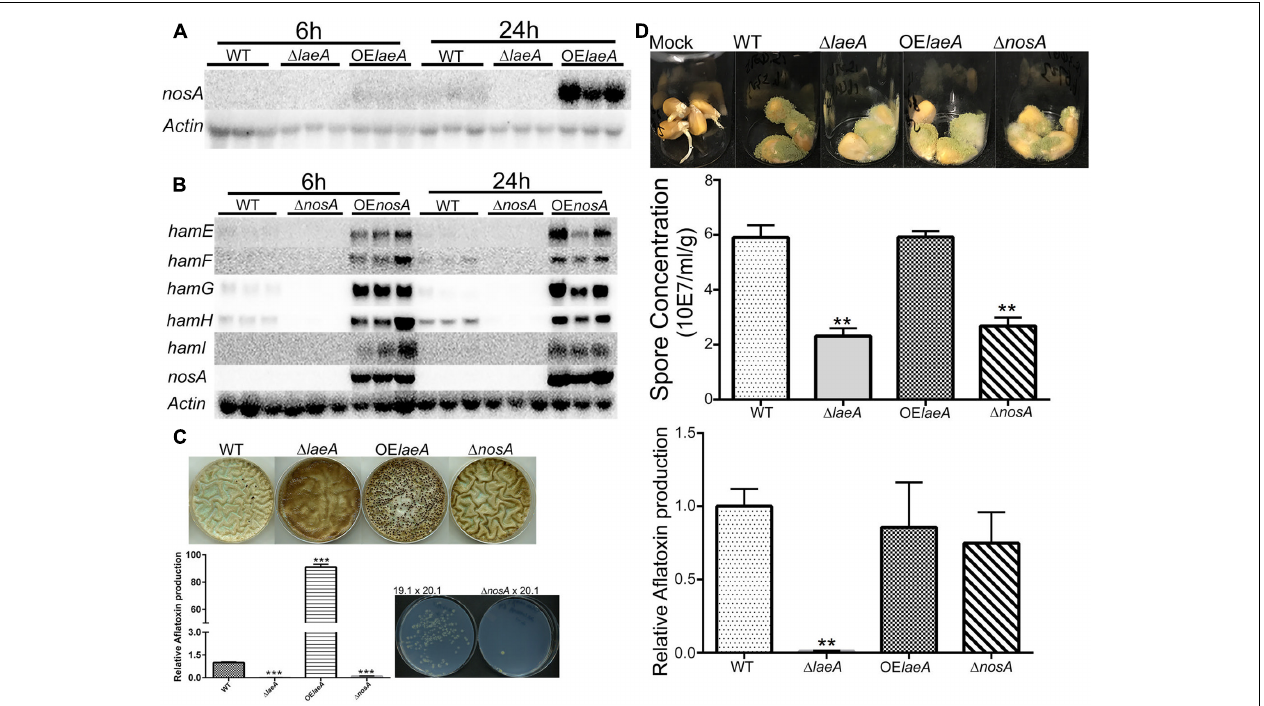
FIGURE 5 | NosA regulation of ham genes and heterokaryon, virulence and aflatoxin production for (cid:49) nosA mutants (A) . LaeA positively regulates nosA expression. The same northern blot as Figure 1 was used for nosA expression. nosA (AFLA_025720). (B) NosA positively regulates hamE-I (using the same culture conditions as Figure 1 ). A. flavus WT (TXZ21.3.7), (cid:49) nosA (TXZ19.1), and OE:: nosA (TXZ22.5). (C) Deletion of nosA (TXZ19.1) results in total or near loss of sclerotia formation, aflatoxin production and heterokaryon formation. NosA deletion was assessed with the strains in Figure 2 and the pictures of WT, (cid:49) laeA and OE:: laeA are from Figure 2 . (D) Deletion of nosA (TXZ19.1) produces less spores but is not affected in aflatoxin biosynthesis on corn. NosA deletion was assessed with the strains in Figure 4 and the pictures of WT, (cid:49) laeA and OE:: laeA are from Figure 4 . Each treatment was replicated three times. P -value, ∗∗ p < 0.01, ∗∗∗ p <